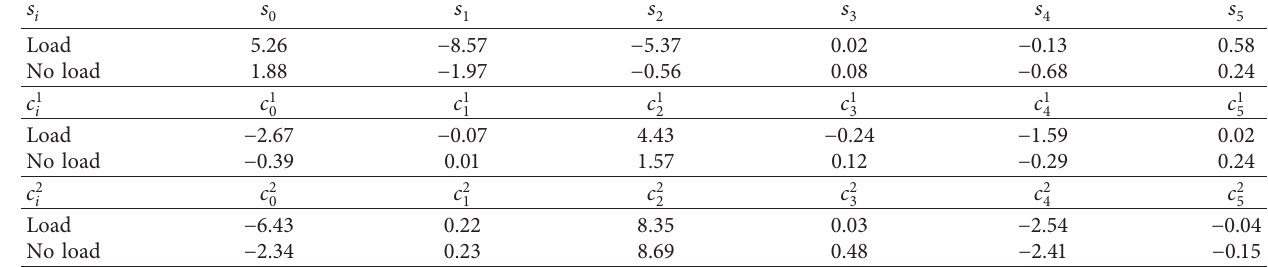
Table 1: Identified parameters of the sEMG-MMG state-space